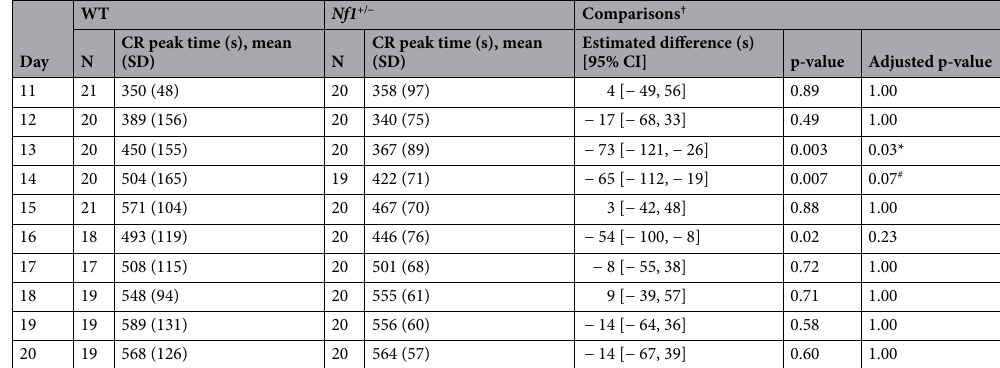
Table 3. Latency to CR peak in the 500 ISI training phase. Latency relative to CS onset, which is set at 0 ms. † The degrees of freedom for all comparisons is 39. # Trend towards a significant difference between genotypes of p < 0.1.*Significant difference between genotypes of p < 0.05. WT wild type.